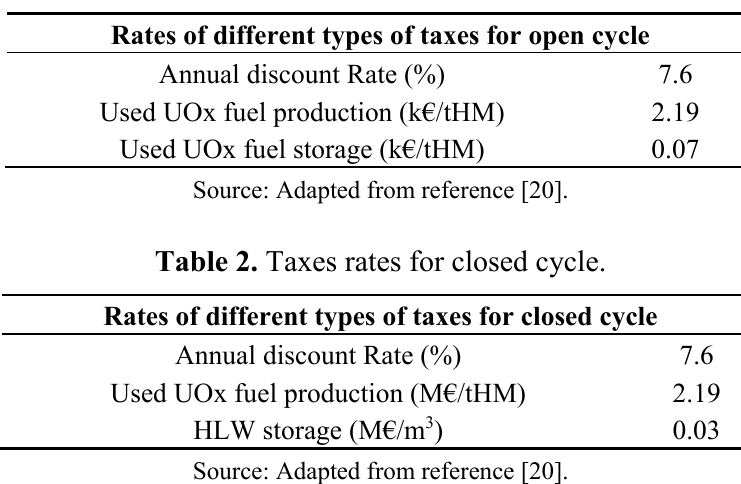
Table 1. Taxes rates for open cycle.